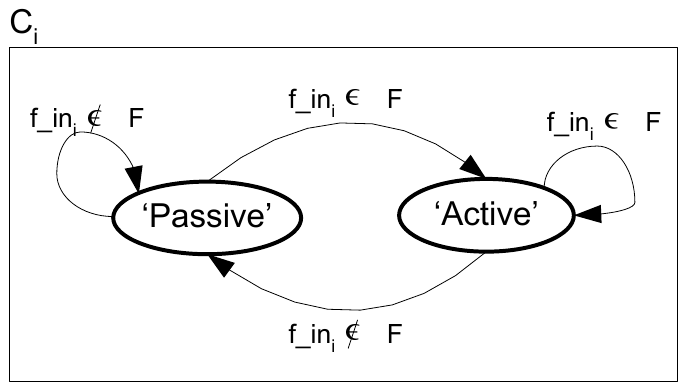
Figure 7. State machine of a component. The state can be changed from Passive to Active and back depending on the structure and content of the activation signal F .